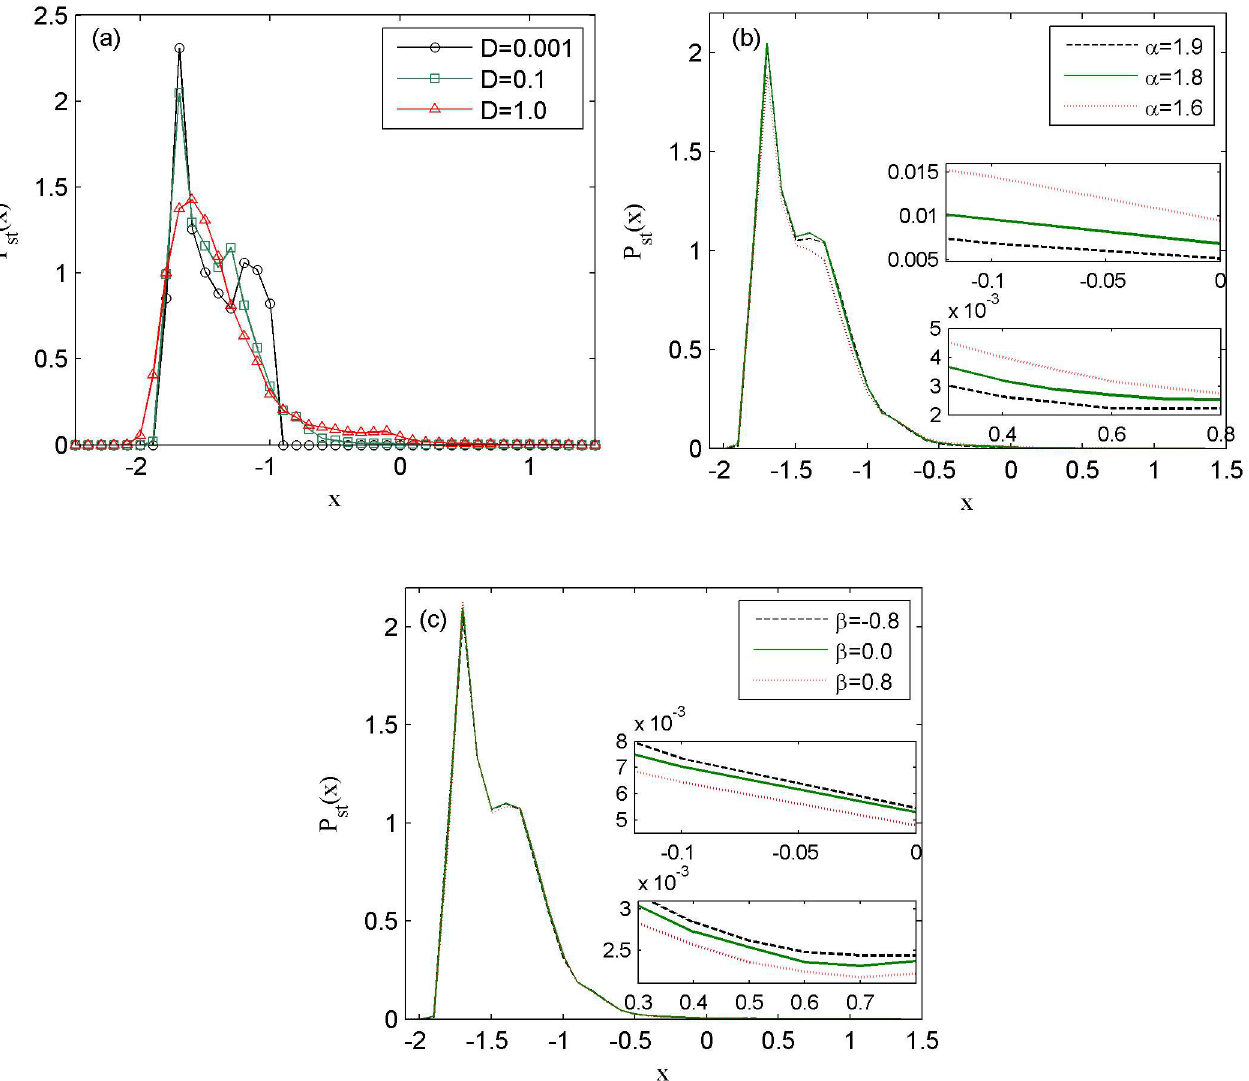
Fig 7. the stationary probability distribution function of membranepotential of neuron under different external radiation-induced magnet flux of Le´vy noise.